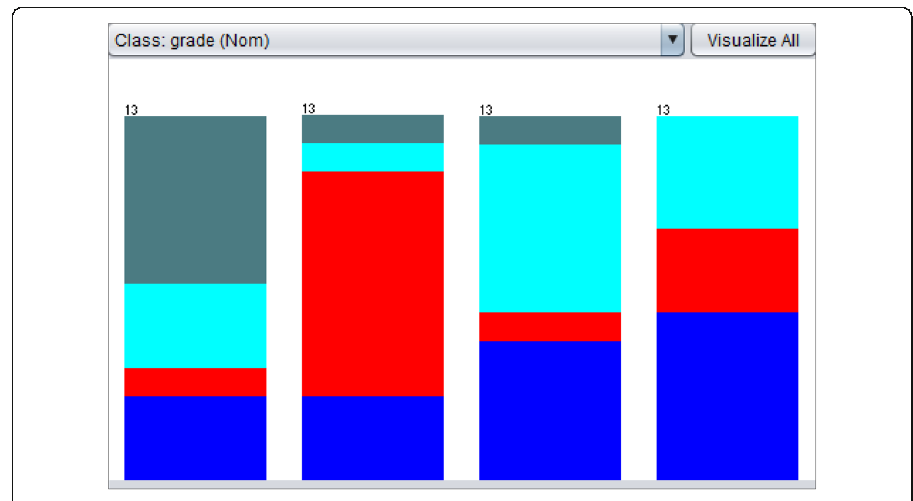
Fig. 3 Discretizing usage intensity